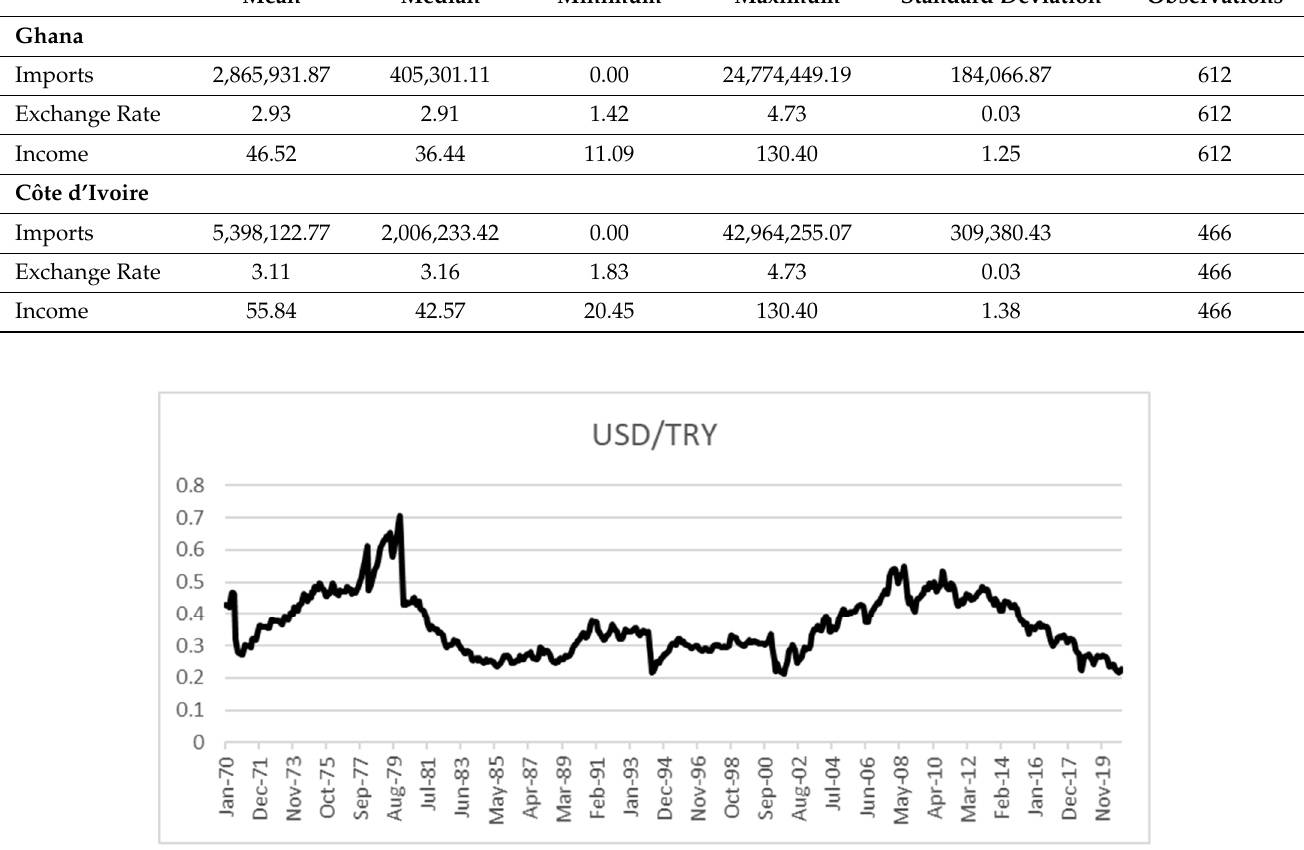
Figure 2. Real exchange rate